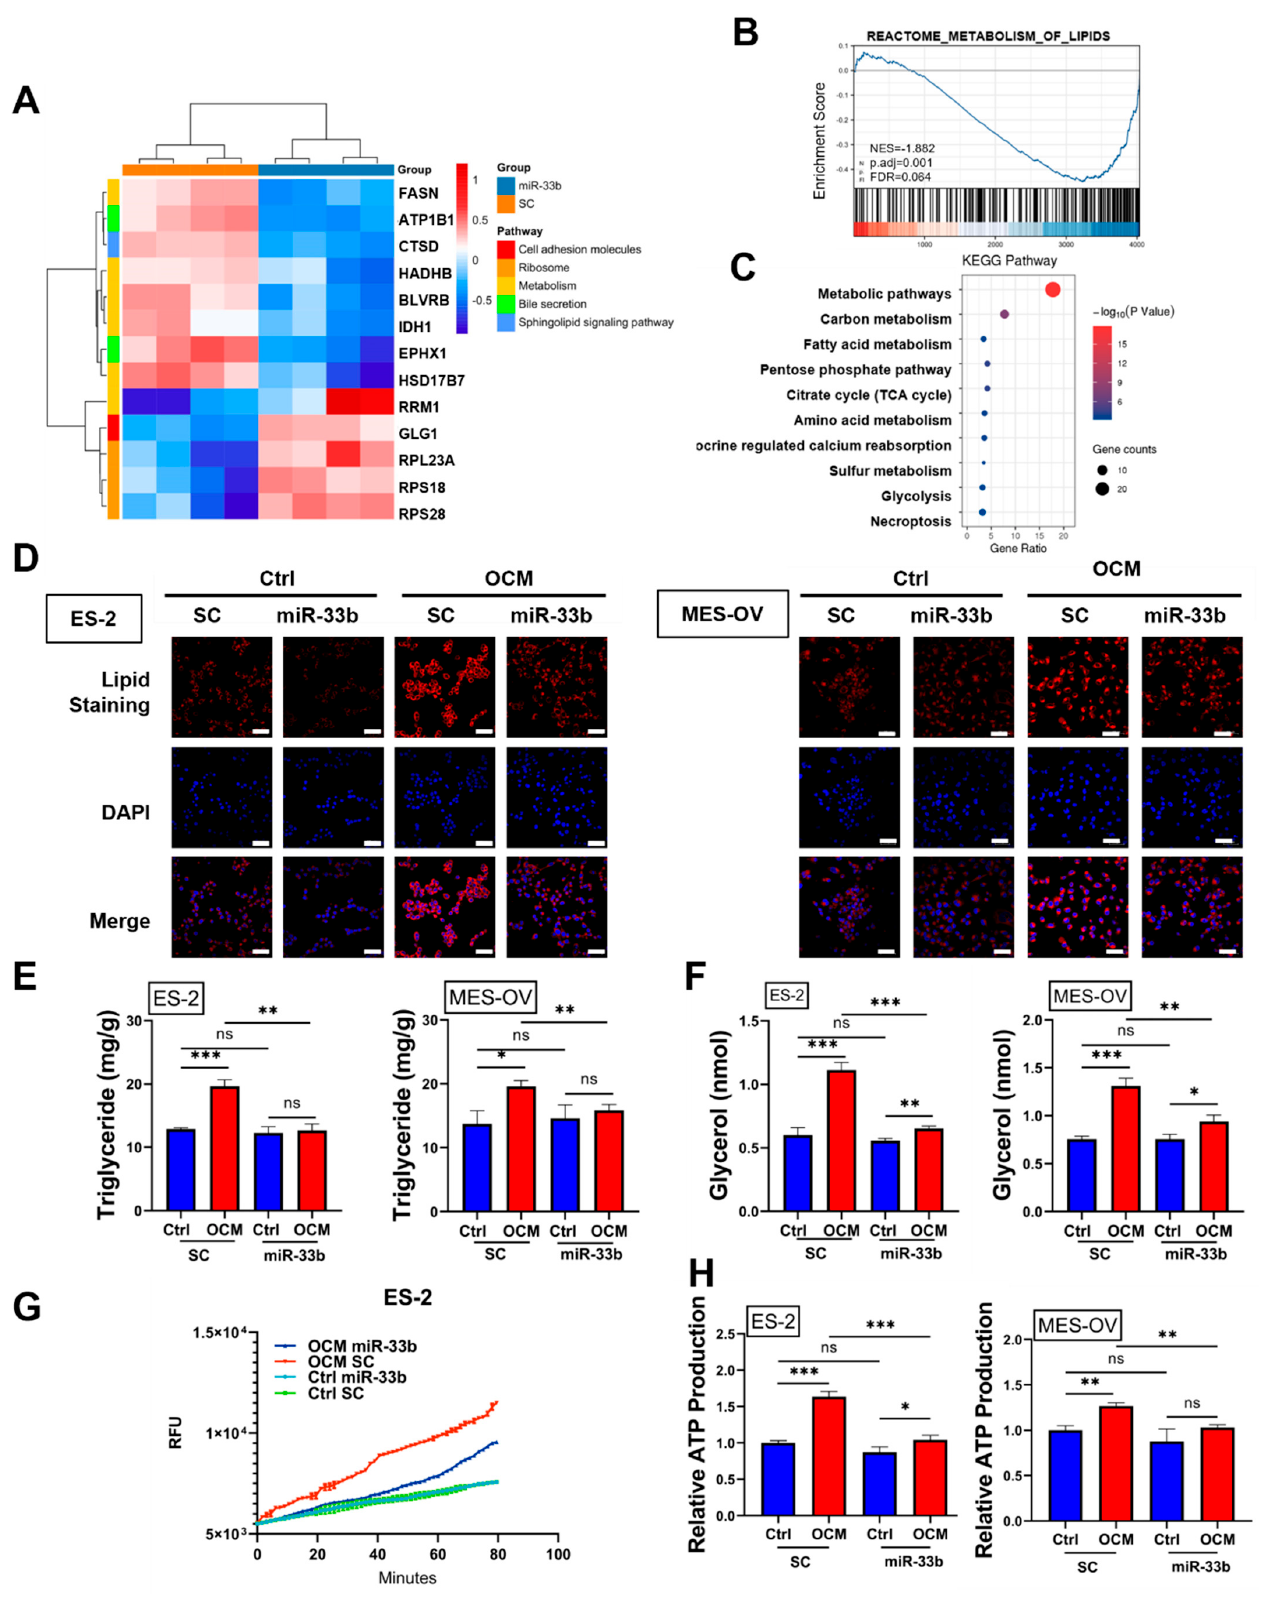
Figure 3. miR-33b regulates OCM-mediated lipid metabolic reprogramming of ovarian cancer cells. ( A ) Stable polyclonal ES-2 cell line with overexpression of miR-33b or scrambled control was treated with OCM for 24 h, and subsequently, total protein was extracted for LC-MS/MS proteomic study. Some of the downregulated and upregulated genes in stable